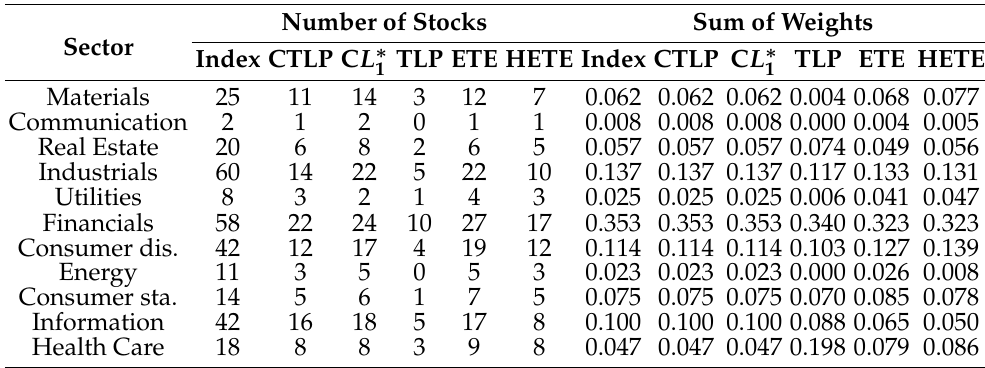
Figure 2. The cumulative profit and loss of portfolios built by different methods and the index in 2018H2. Table 10. The number of stocks and the sum of weights within sectors in selected portfolio by different methods and the index in 2018H1.